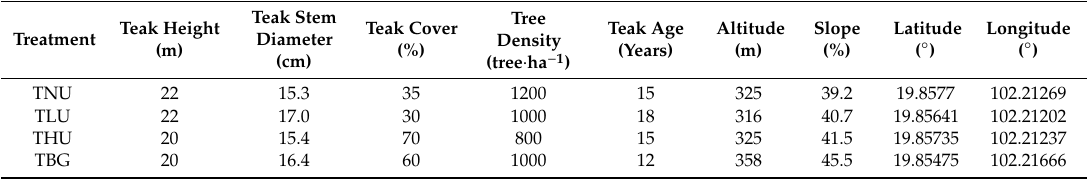
Table 1. Characteristics of the four experimental sites in 2017, measured on 14 December 2017, in Ban TLU: teak with low density of understory; THU: teak with high density of understory; TBG: teak